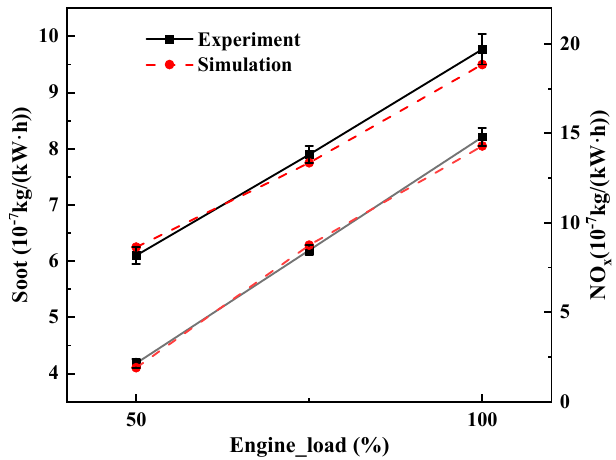
Figure 5. Engine validation results for soot and NO x emissions.